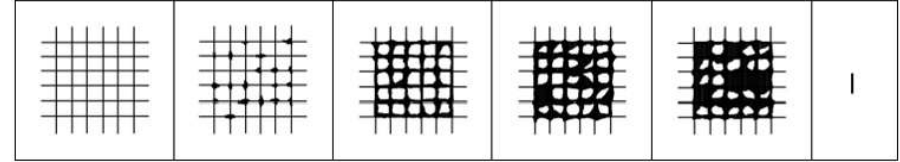
Figure 9. Crosshatch classification. On the left-hand side class 0 is depicted. On the right-hand side class 4 is depicted. Class 5 corresponds to a complete removal of the coating.